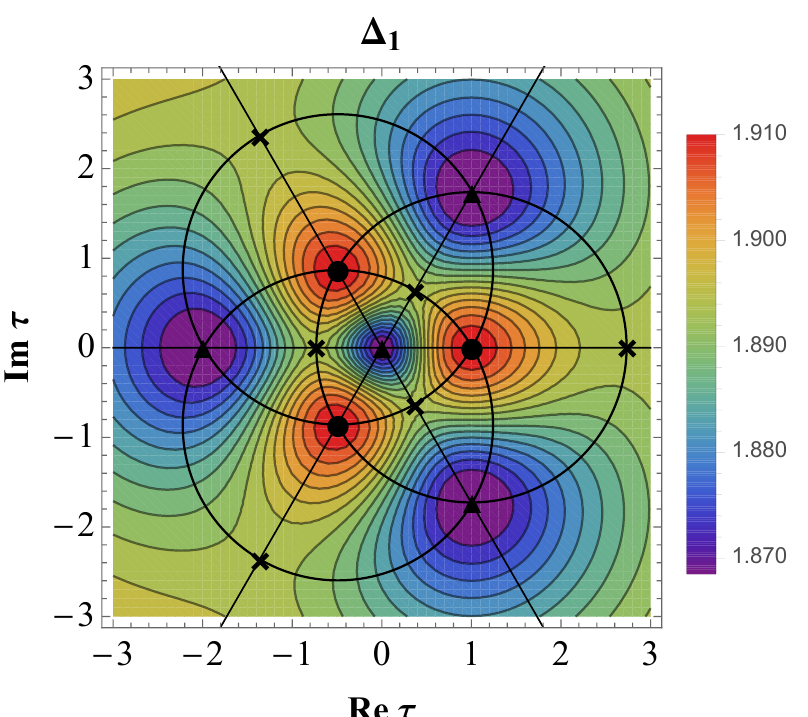
Figure 2 . The 3-loop Pad(cid:19)e[1,2] resummed 4 (cid:0) " -expansion values for the singlet. The cross, circle, and triangle denote values of (cid:28) that correspond to the Z 2 (cid:2) Z 2 , cWZ 3 , and XYZ models,